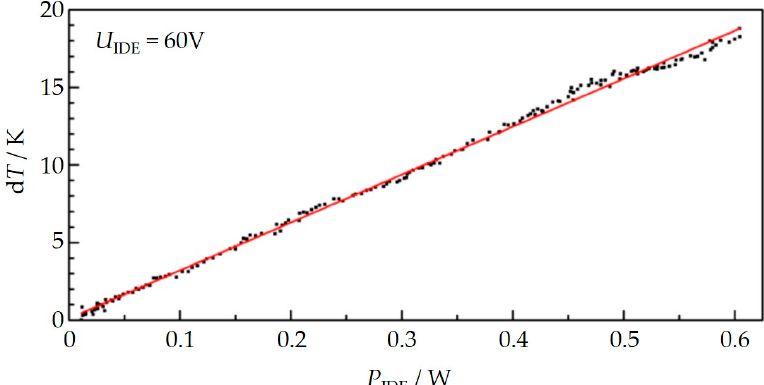
Figure 7. Internal self-heating of the device: Correlation of the increase of the sensor temperature (determined from the resistance of the platinum structure) and the calculated electrical power on the sensing electrodes during soot deposition when 60 V were applied, calculated from the data in Figure 6.